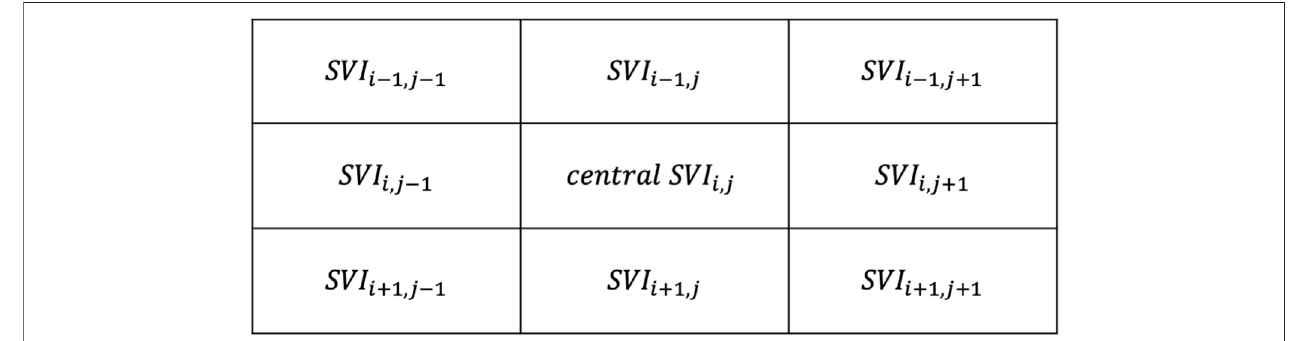
FIGURE 4 | Neighbors to the central region at position i , j , with i representing rows and j representing columns.